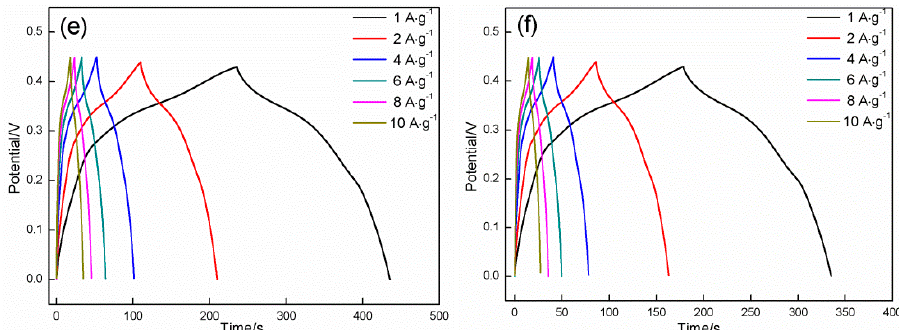
Figure 12. Galvanostatic charge/discharge curves recorded on the samples at different current densities: ( a ) Sample A; ( b ) Sample B; ( c ) Sample C; ( d ) Sample D; ( e ) Sample E; ( f ) Sample F.